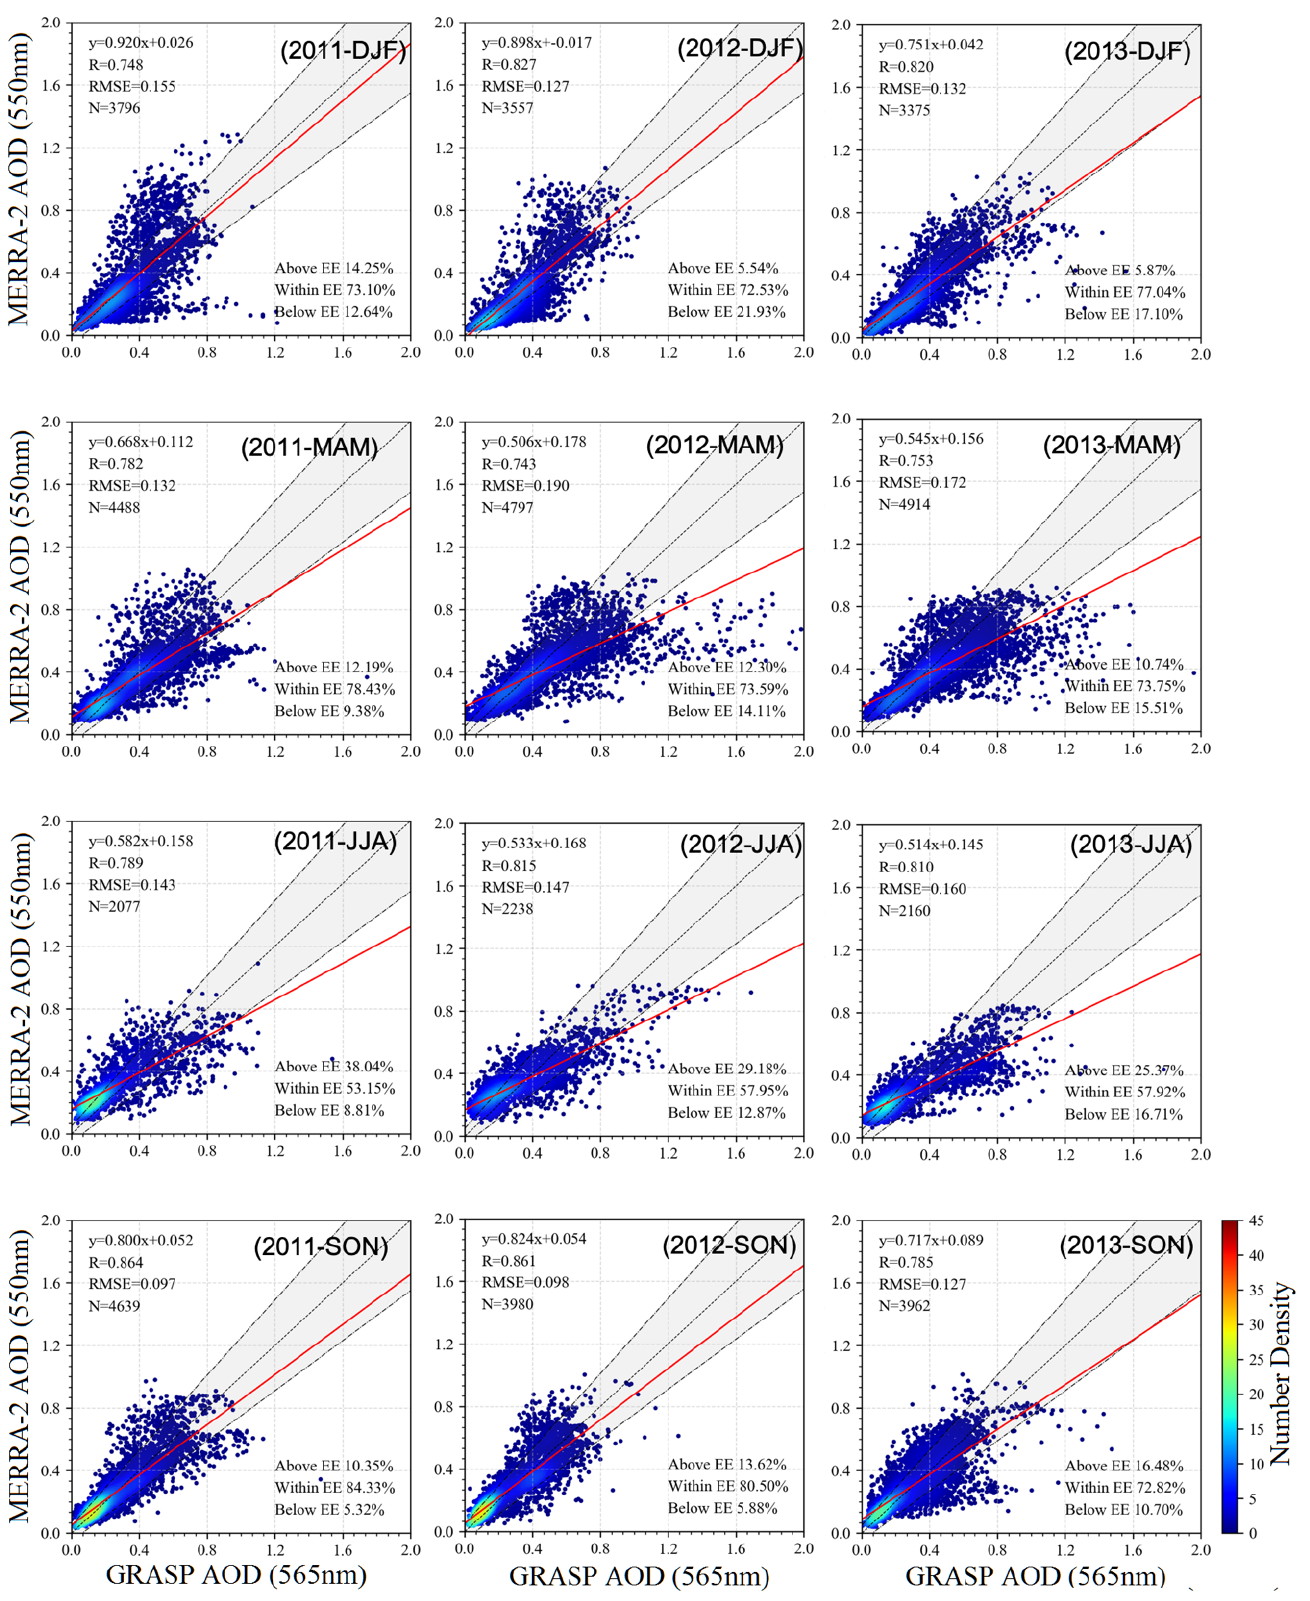
Figure 8. Intercomparison MERRA-2 seasonal AOD with PARASOL/GRASP “Models” over China. The grey dashed line represents the one-to-one line and EE line. The red, solid line represents the fitting line.